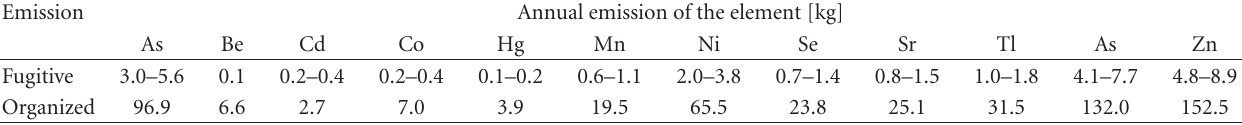
Table 9: Annual emission from the coke oven battery in Carbo-Koks